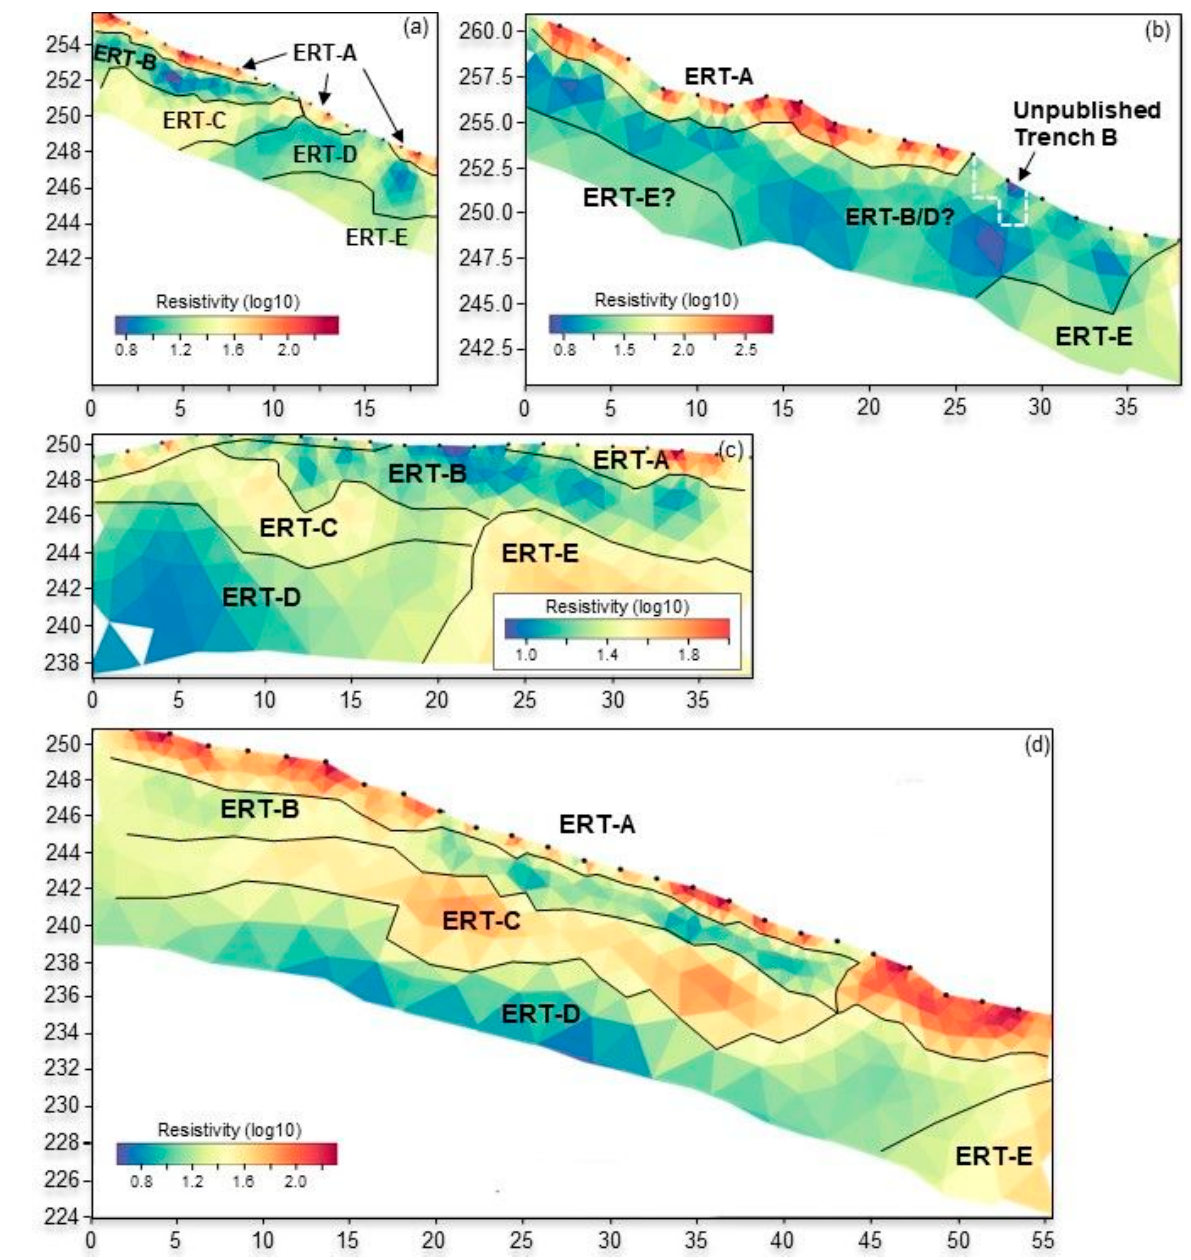
Figure 4. Electrical Resistivity Tomography (ERT) results from the Kremenjak Valley: ( a ) profile ERT-3; ( b ) ERT-1; ( c ) ERT-8; ( d ) ERT-9. All the subpanels display jointed inversions of resistivity